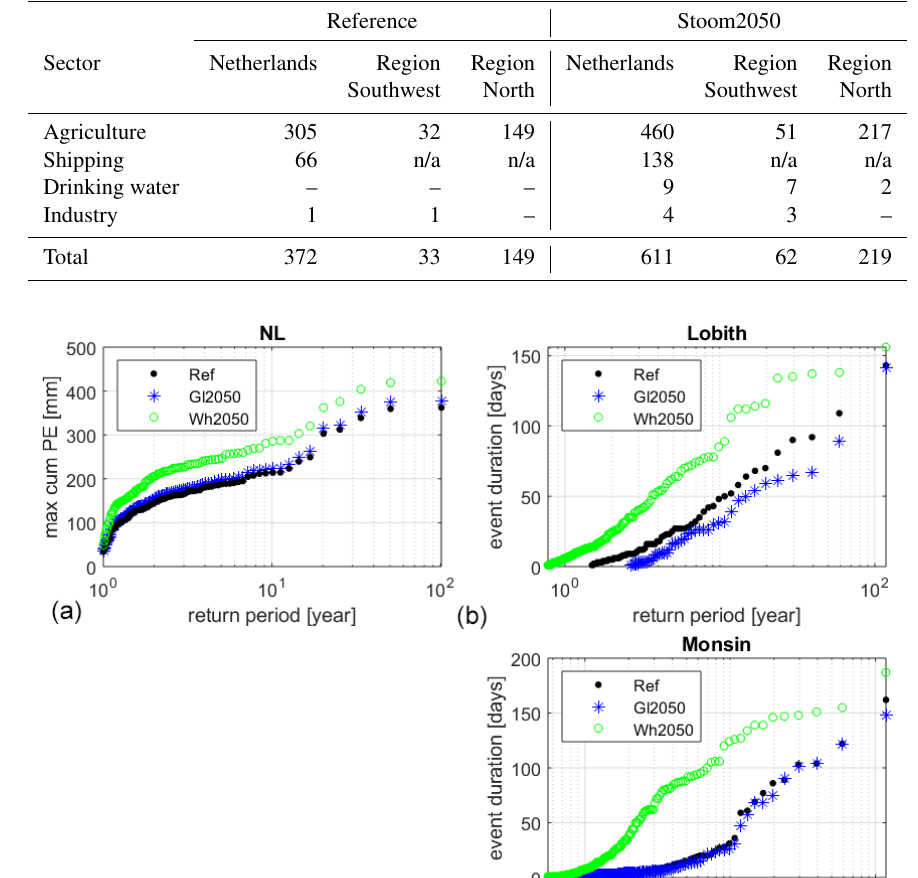
Table 3. Current and future drought risk (in millions of euros per year, excluding VAT) in the Netherlands and the two focus regions when continuing current policy, broken down by sector. Note that n/a stands for not applicable.